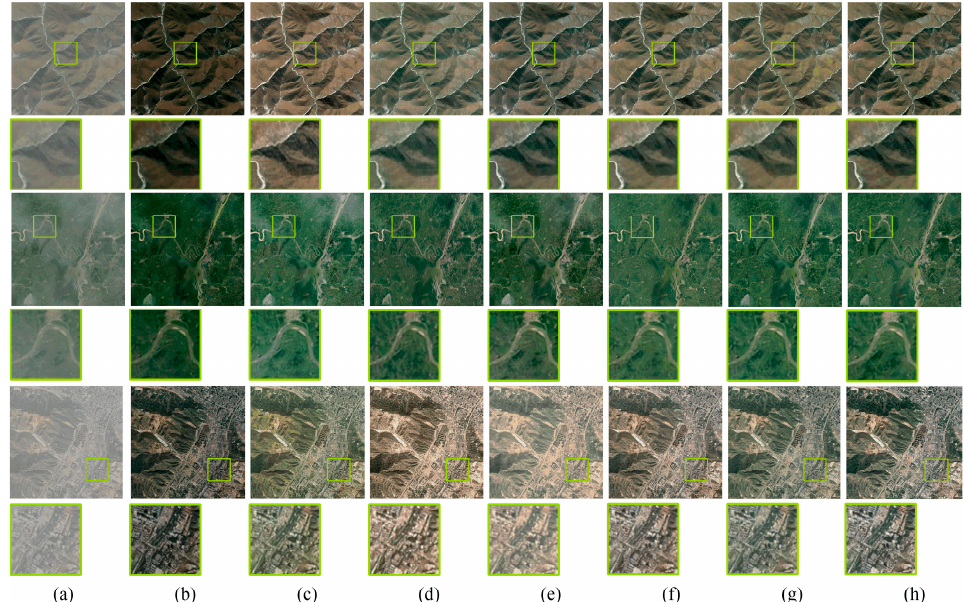
Figure 6. Results of each method for RICE1. ( a ) Cloudy images; ( b ) DCP; ( c ) cGAN; ( d ) SpAGAN; ( e ) McGAN; ( f ) AMGAN-CR; ( g ) DC-GAN-CL; ( h ) cloud-free images.